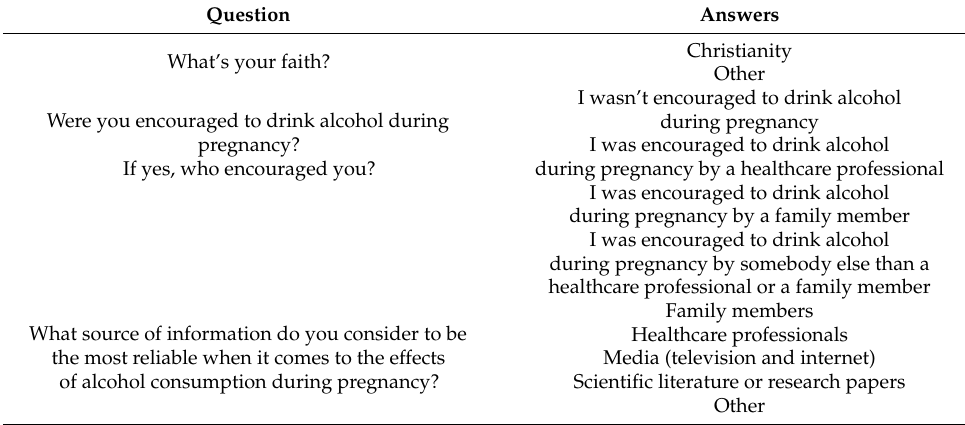
Table 1. Answers assigned to open-ended questions.